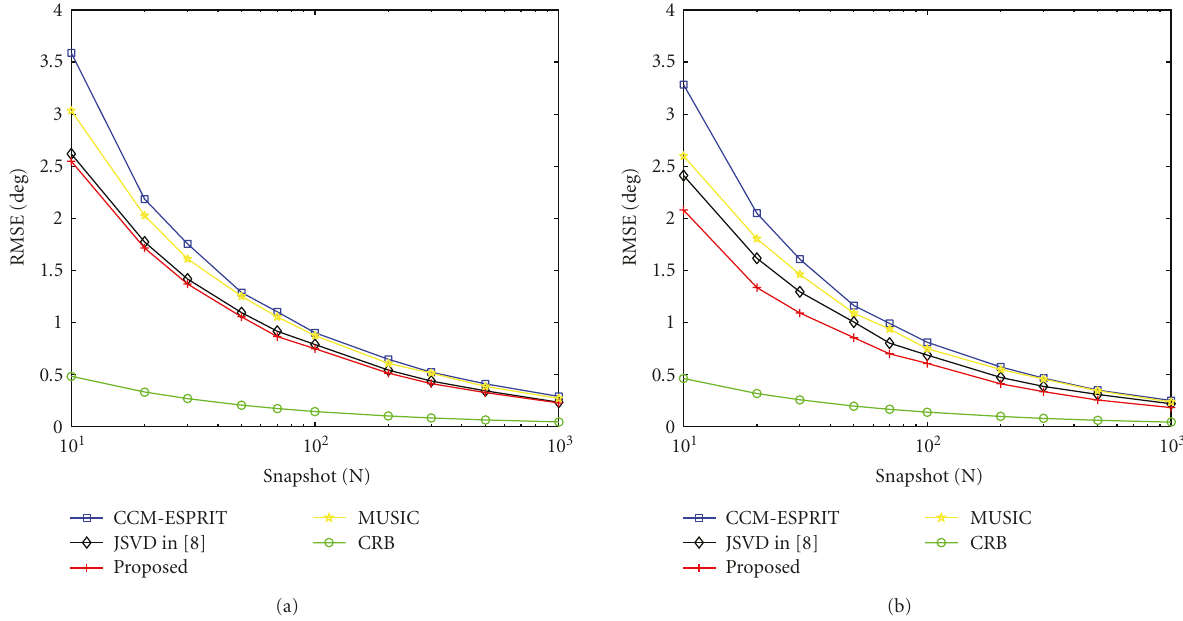
Figure 4: JRMSE of joint elevation and azimuth angle estimation versus the number of snapshots for two uncorrelated sources with equal power at the DOA: (a) (45 ◦ , 110 ◦ ) and (b) (55 ◦ , 100 ◦ ).